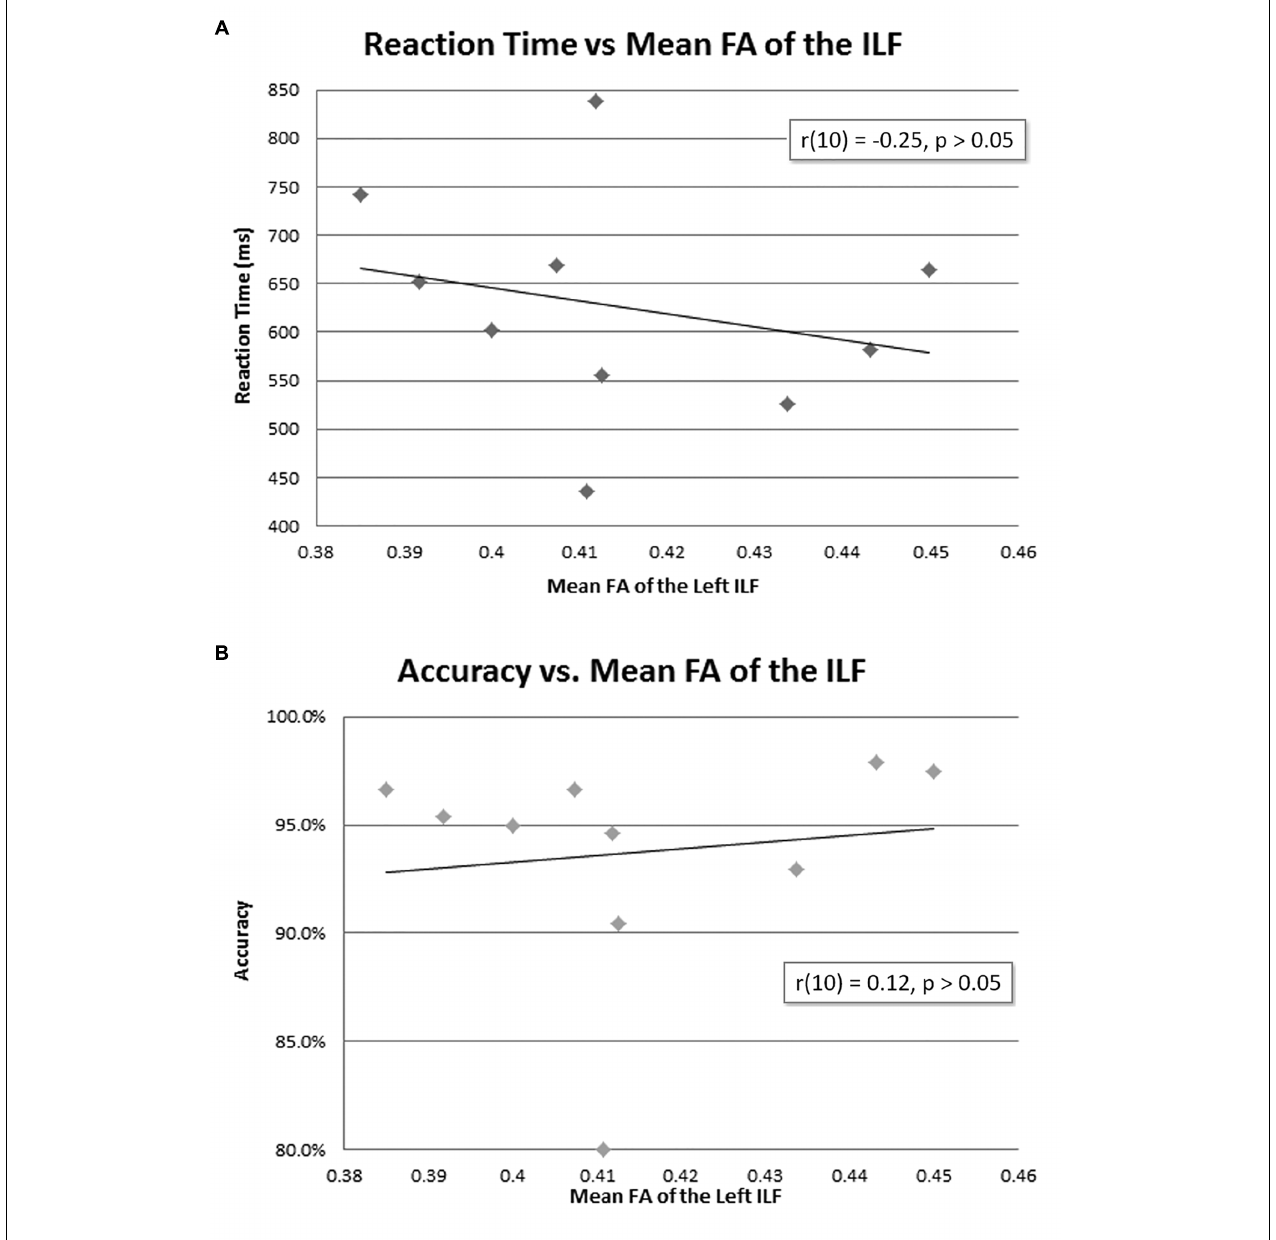
FIGURE 4 | Behavioral data and mean FA of the left ILF. No correlation was found between mean FA of the left ILF and reaction time (A) or accuracy (B)